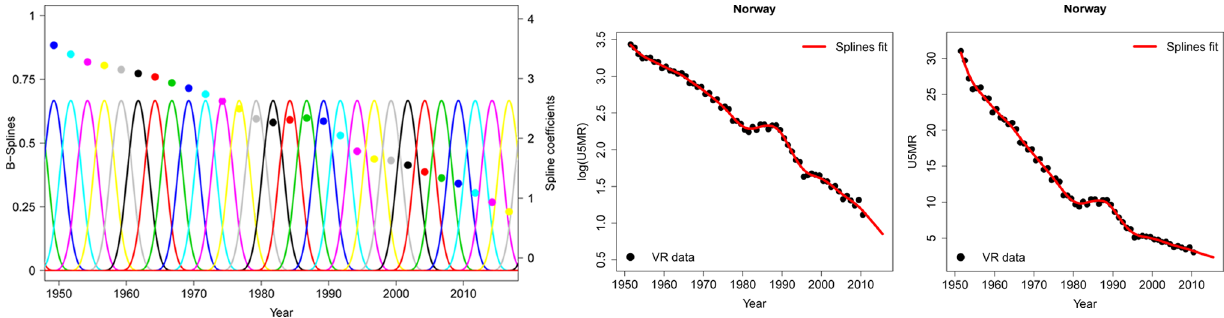
Figure 1. Illustration of the B-spline regression model for Norway. From left to right: B-splines and their corresponding spline coefficients (plotted in the same color), observed log(U5MR) and U5MR (black dots) plotted against time, together with the spline estimates (red line). The spline estimate for log(U5MR) in each year is the sum of the non-zero B-splines in that year weighted by their respective spline coefficients. doi:10.1371/journal.pone.0101112.g001 PLOS ONE |